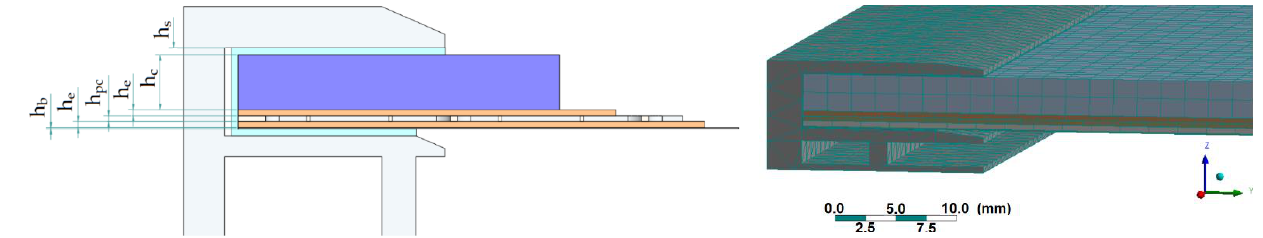
Figure 13. Layer thickness parameters in the FE model.